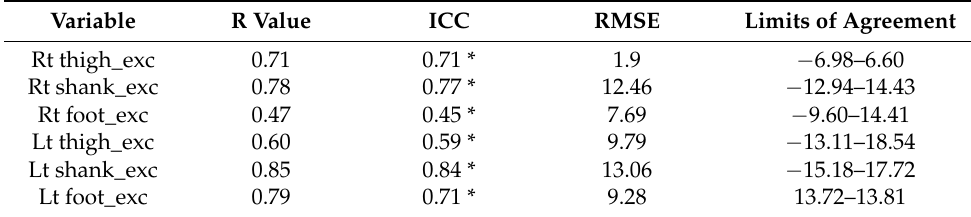
Table 2. Validity of segment angle excursions (exc) during dance testing.